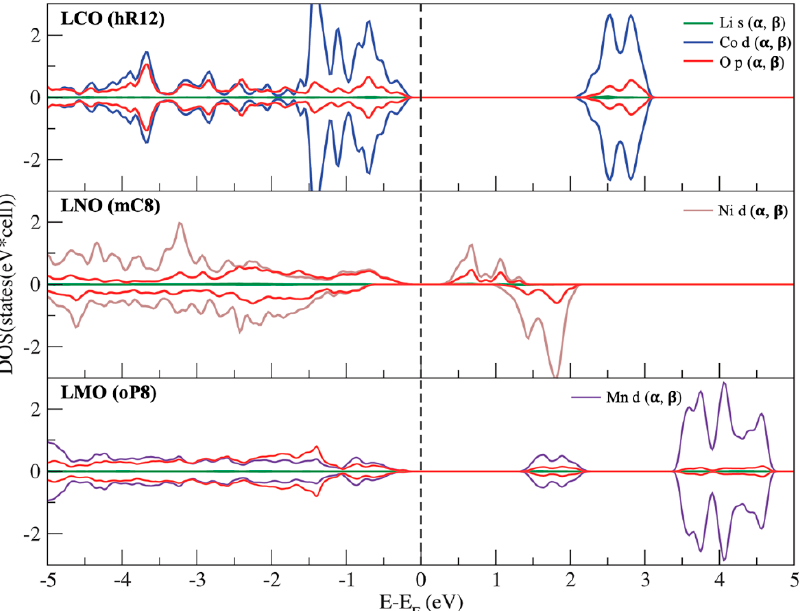
Figure 5. PDOS of LTMO compounds, each at its most stable phase. Upper-panel rhombohedral electronic structure of LCO (hR12), middle-panel monoclinic electronic structure of LNO (mC8) and bottom-panel orthorhombic electronic structure of LMO (oP8). Positive and negative PDOS values refer to spin α and β , respectively.